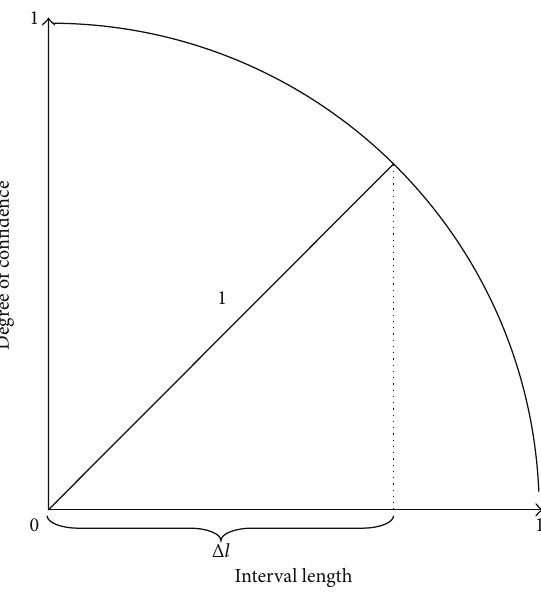
Figure 1: Evaluation of the Degree of